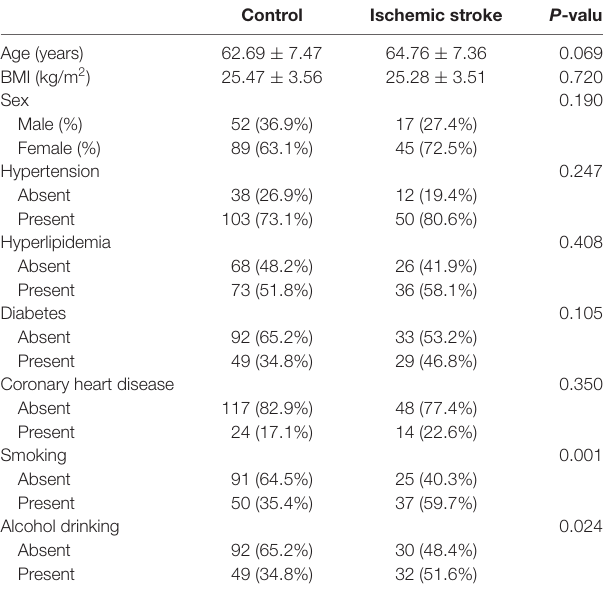
TABLE 2 | Comparison of ocular parameters between the two groups. TABLE 1 | Baseline characteristics of patients. Control Ischemic stroke P -value Control Ischemic stroke P -value